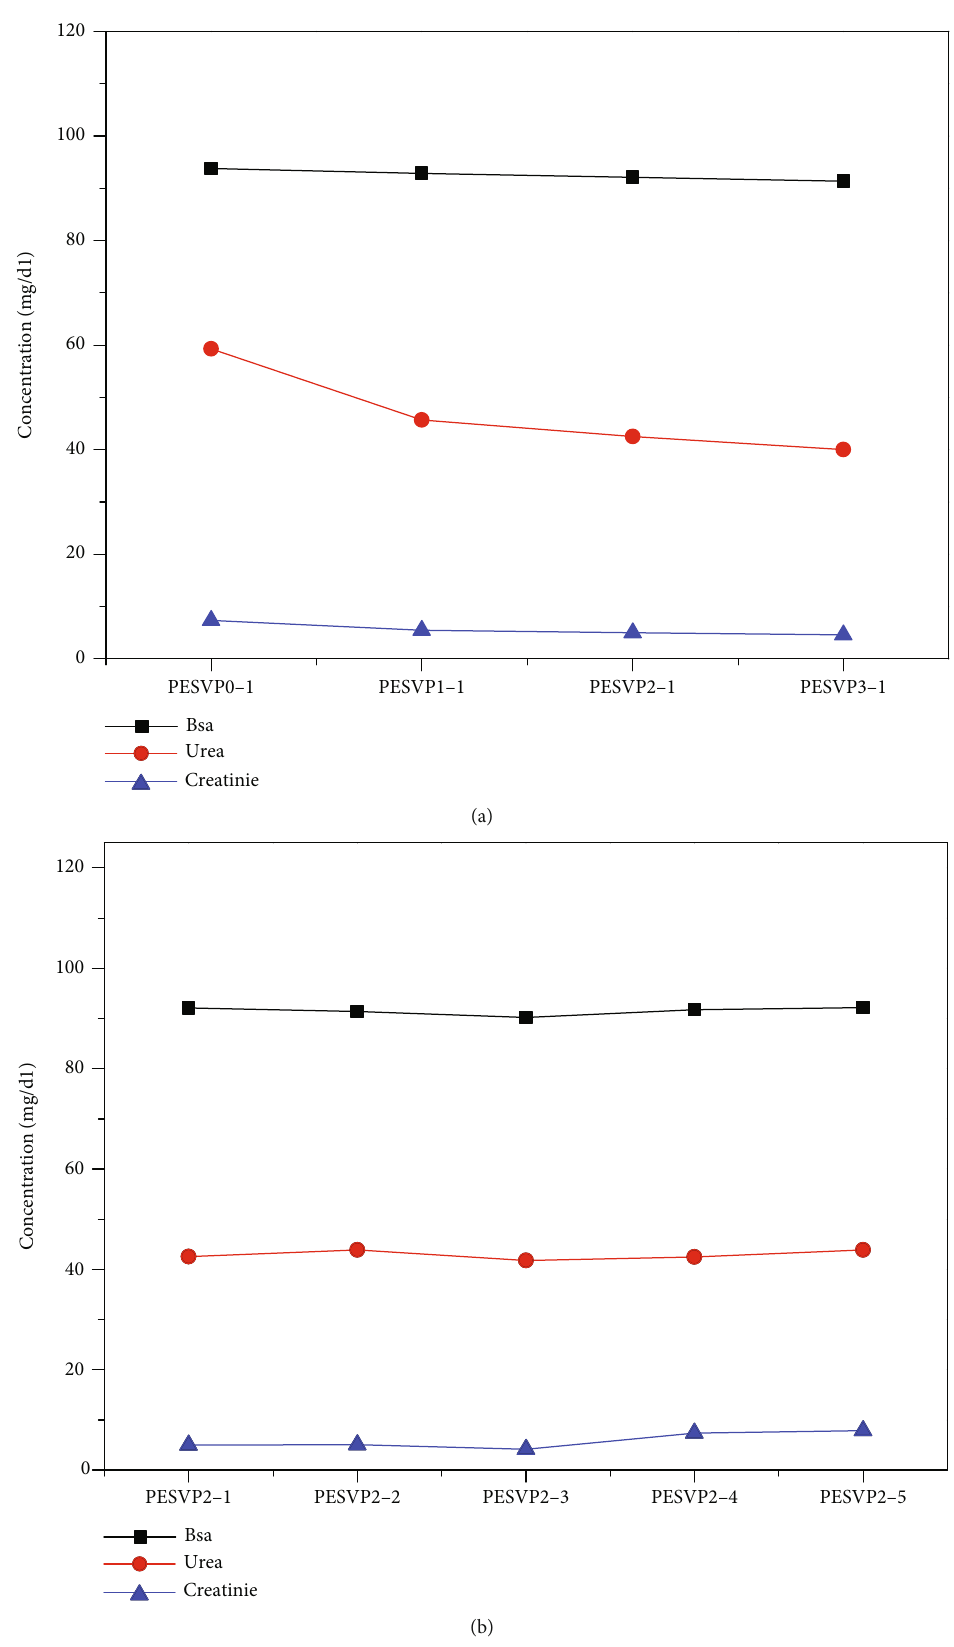
Figure 9: Test results of fi ltration e ffi ciency of toxin substances in PESVP